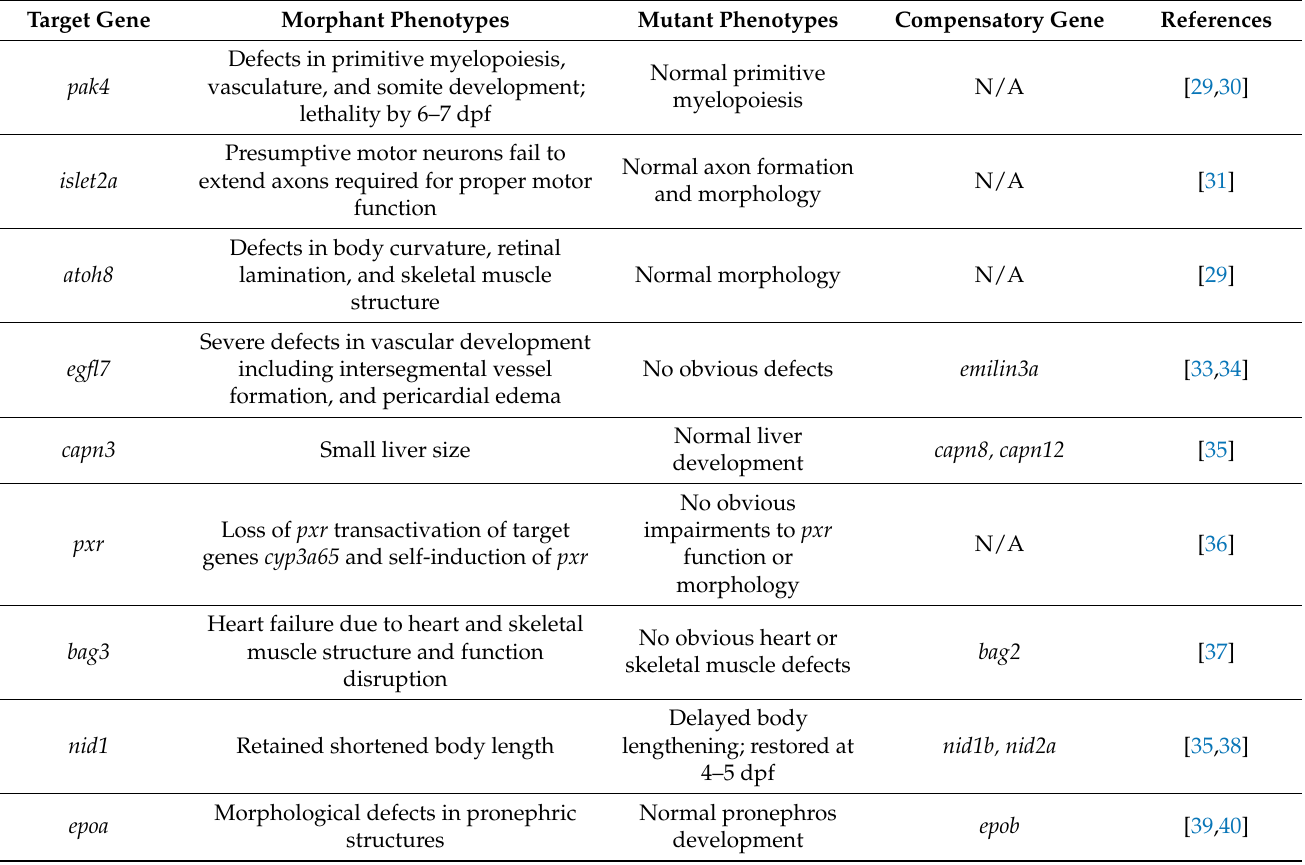
Table 1. Summary of morphant and mutant phenotype disjunction. Dpf: days